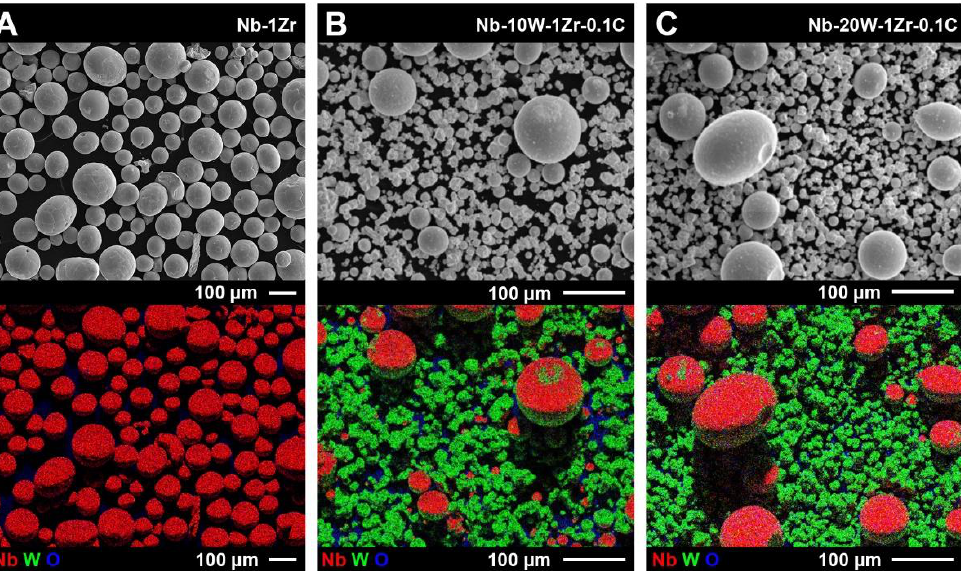
Figure 4. SEM and EDS composite RGB images of ( A ) spheroidized Nb-1Zr powder, ( B ) spheroidized and blended Nb-10W-1Zr-0.1C, and ( C ) spheroidized and blended